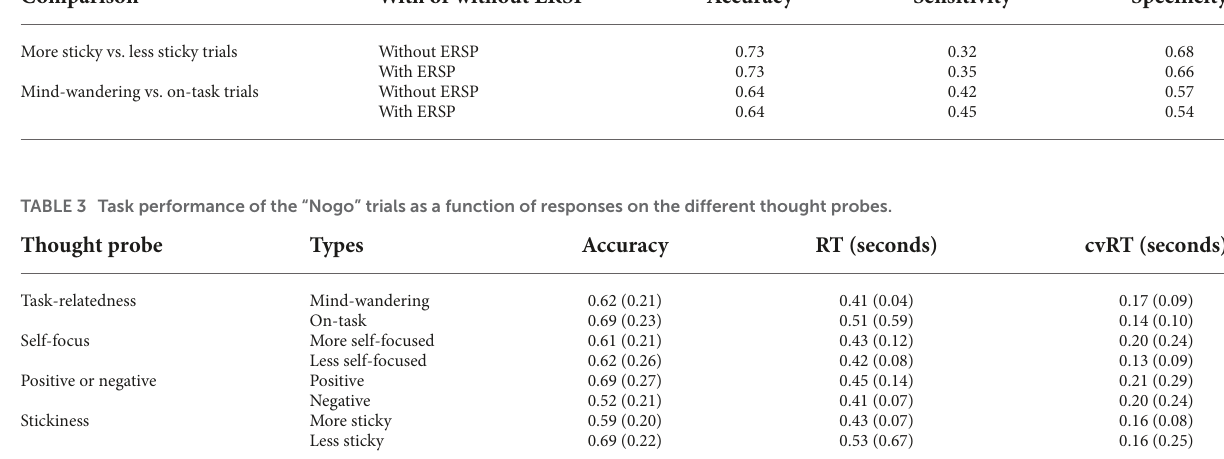
TABLE 2 The accuracy, sensitivity, and specificity of the support vector machine model with and without the ERSP value included. Comparison